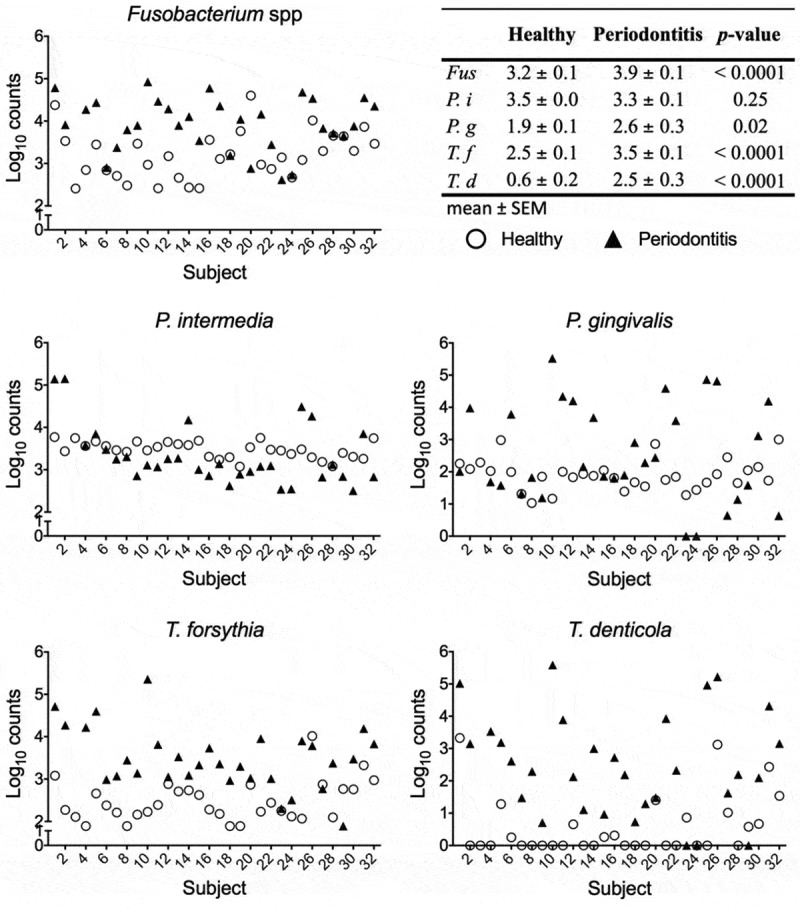
The presence of bacteria associated with periodontitis.The log10 counts for the bacterial species tested for each subject are shown (O Healthy, ▲ Periodontitis). The table shows a statistically significant difference between the two groups for all species except P. intermedia.